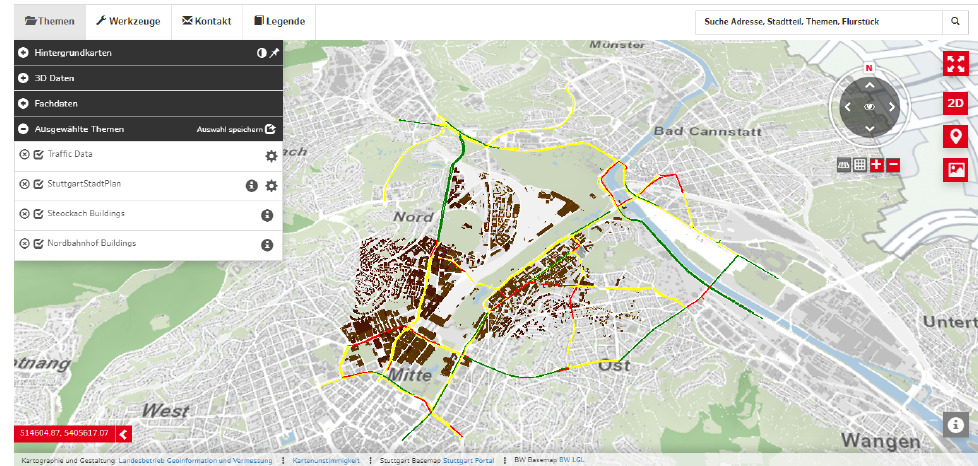
Figure 2. Masterportal interface with traffic layer and 3D city models